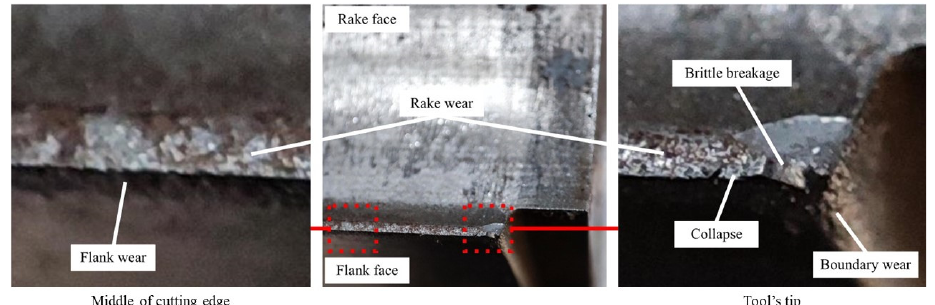
Figure 2. Tool failure mode.